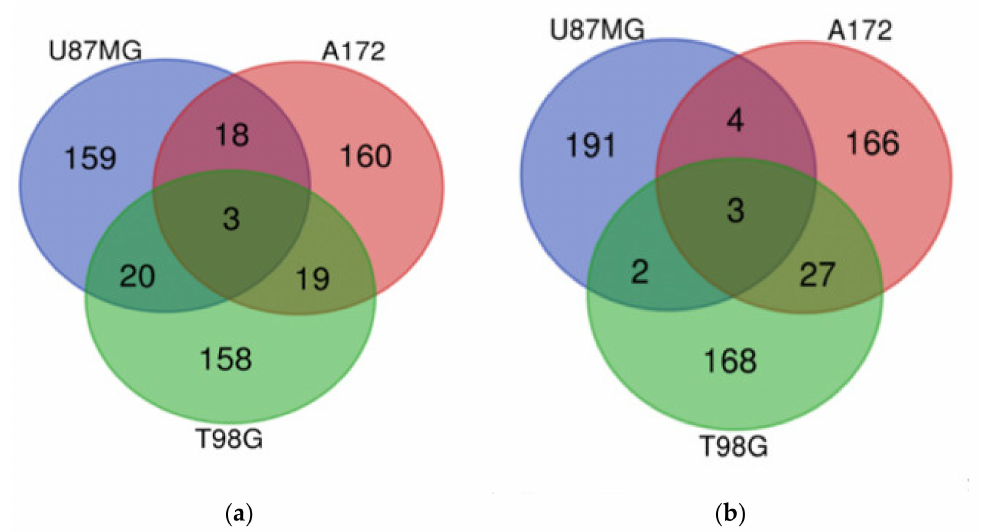
Figure 4. Venn diagrams showing the partitioning of the 200 genes most significantly modulated by Mardepodect in U87MG, A172, and T98G cells; ( a ) upregulated genes; ( b ) downregulated genes. Table 3. Genes modulated by Mardepodect, shared between U87MG, A172, and T98G cells. Sharing Groups Upregulated